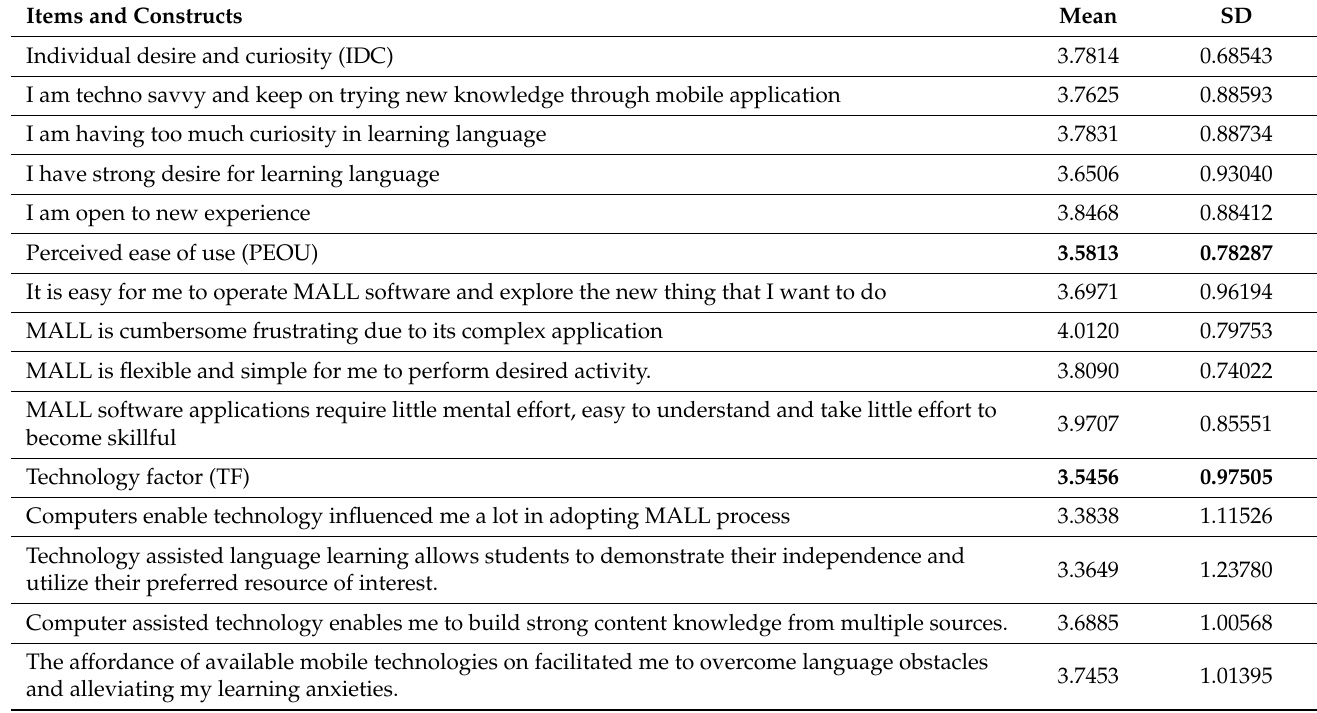
Table 5. Factors of mobile assisted language learning: descriptive